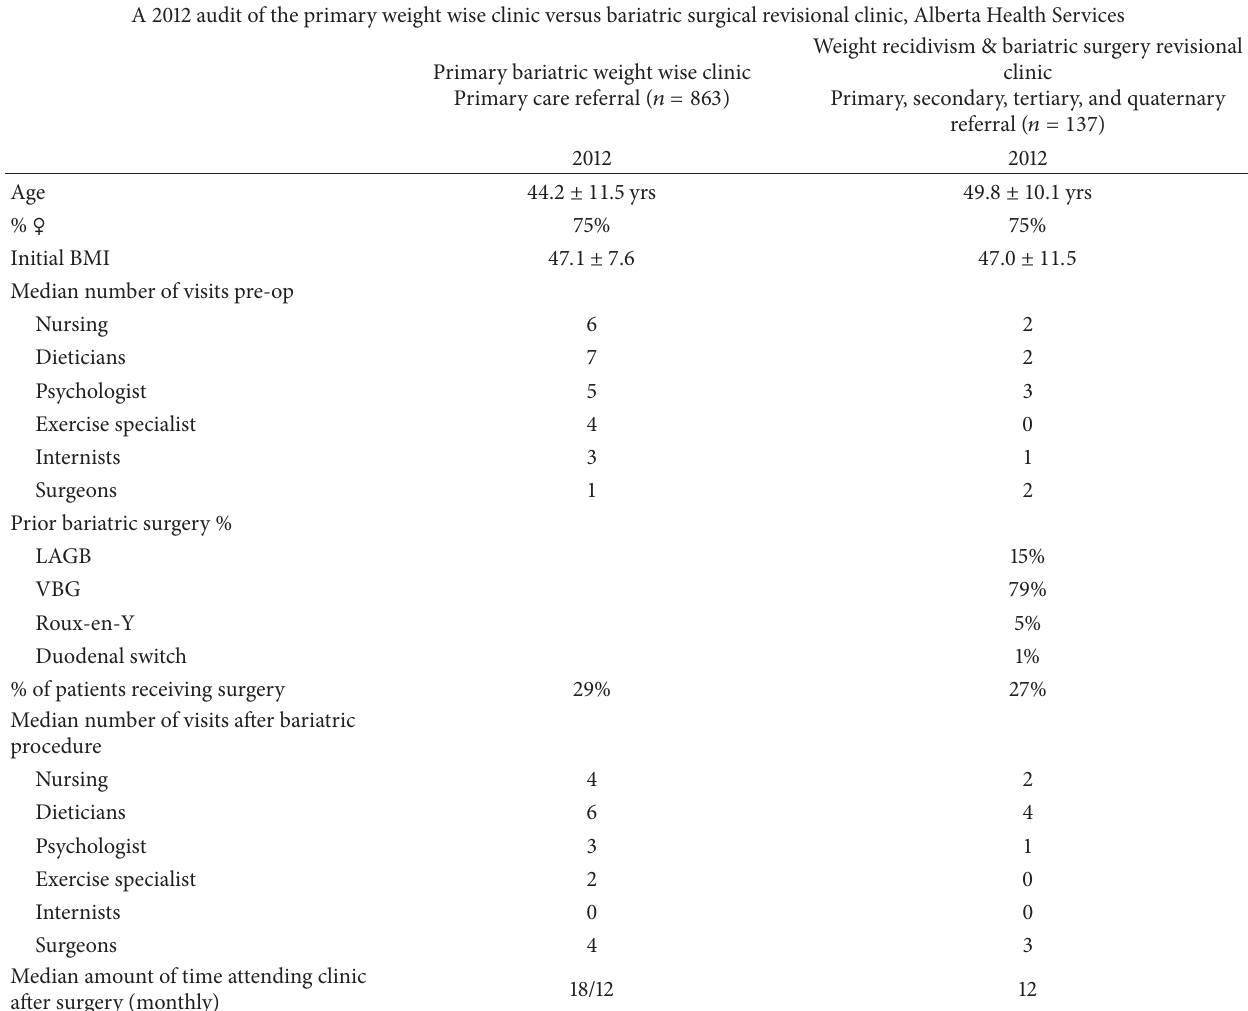
Table 1: Primary weight wise clinic versus bariatric surgical revisional